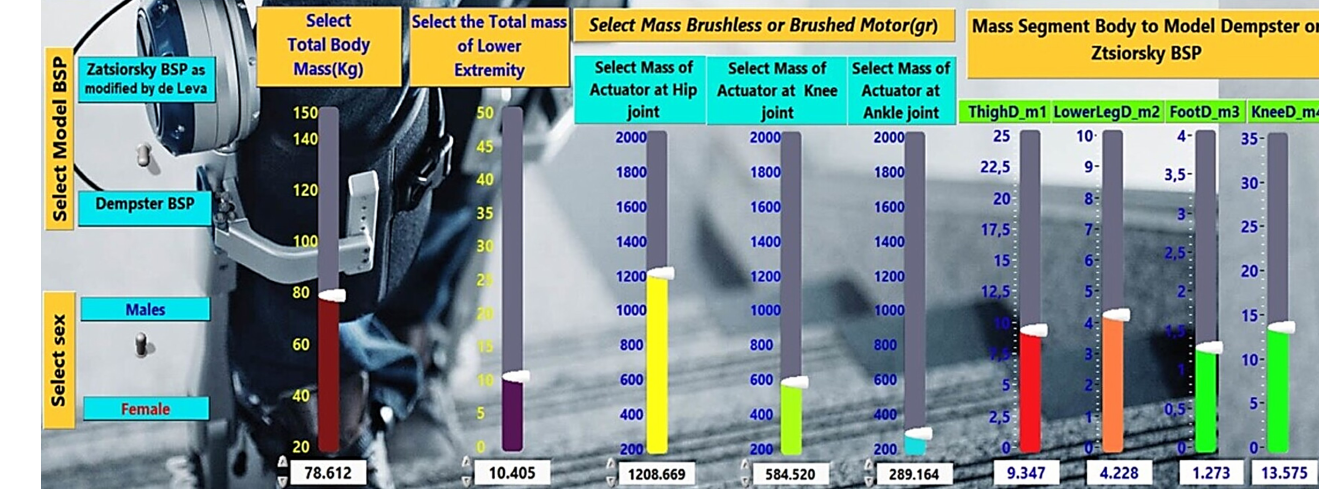
Figure 9. The mass of each part of the lower limb is calculated in relation to its total